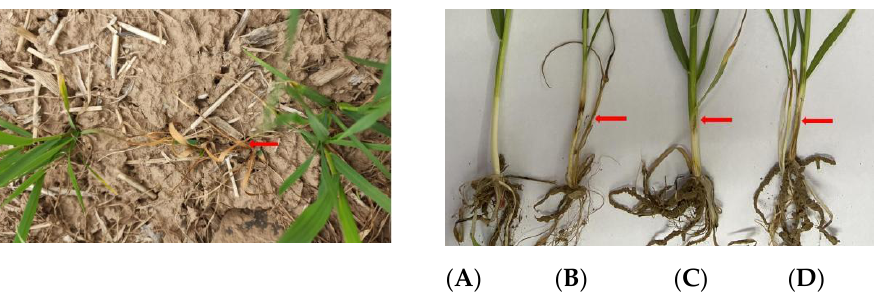
Figure 1. Dead seedlings ( left ) and dead tillers ( B , right ) in the field. ( A ), the healthy seedling; ( B ), the dead tiller; ( C , D ), the infected sheath.